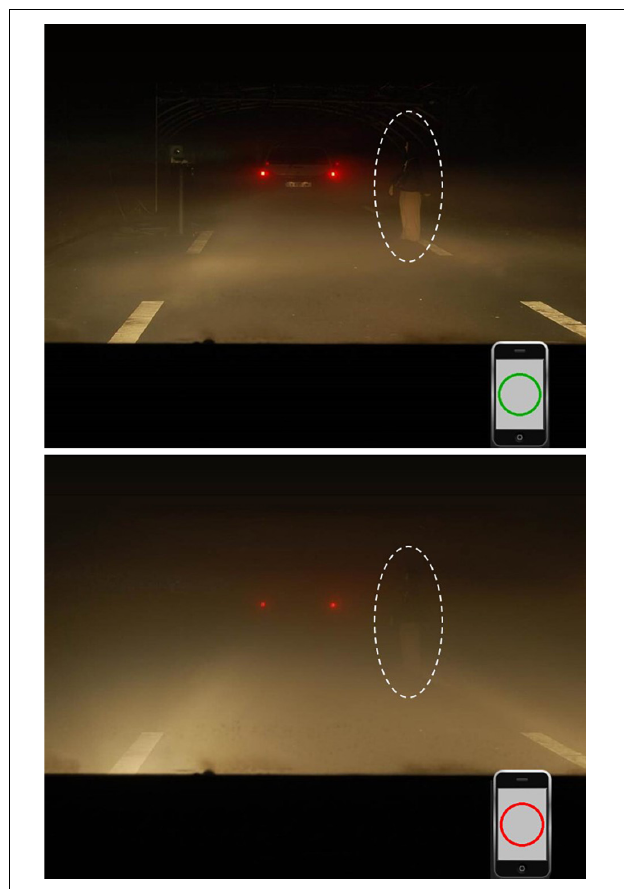
FIGURE 2 | Examples of driving scene pictures used in the driving visual search task. Participants were required to identify as fast as possible the target (e.g., a child pedestrian, surrounded here by a dotted line for clarity, or a roe deer, not represented here) with pictures taken under low (top) or high fog density (bottom) . In 75% of the trials, an irrelevant low (e.g., green – top ) or high (e.g., red – bottom ) social reward distractor could appear on the screen of a smartphone embedded in each picture (the smartphone displayed an empty gray screen in the remaining trials - not represented here).